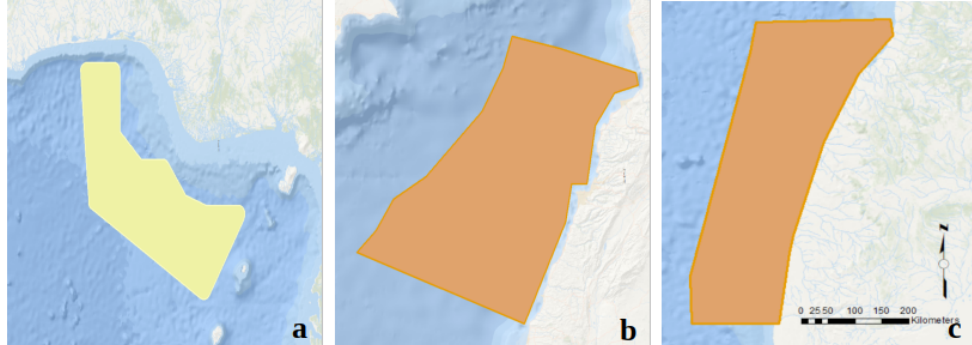
Figure 6. Location maps of the considered Areas Of Interest (AOI) captured from the Sentinel-1 sensor: ( a , b ) two areas of the Atlantic Ocean coast are located in Southern Africa (Nigeria and Namibia), ( c ) the Mediterranean Sea in Western Asia (Lebanon). The orange areas are used for training and validation, and the yellow area is used for testing.